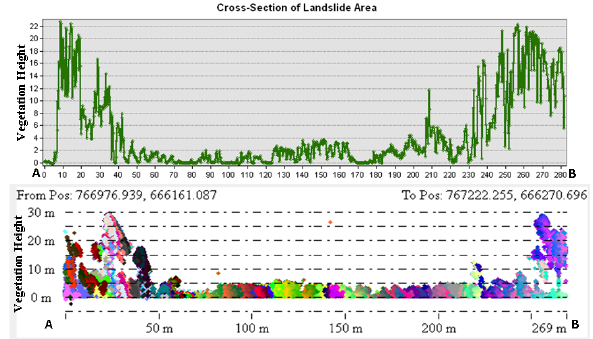
Figure 3. Irregularity in tree height on landslide area from toe (A) to crown area (B)